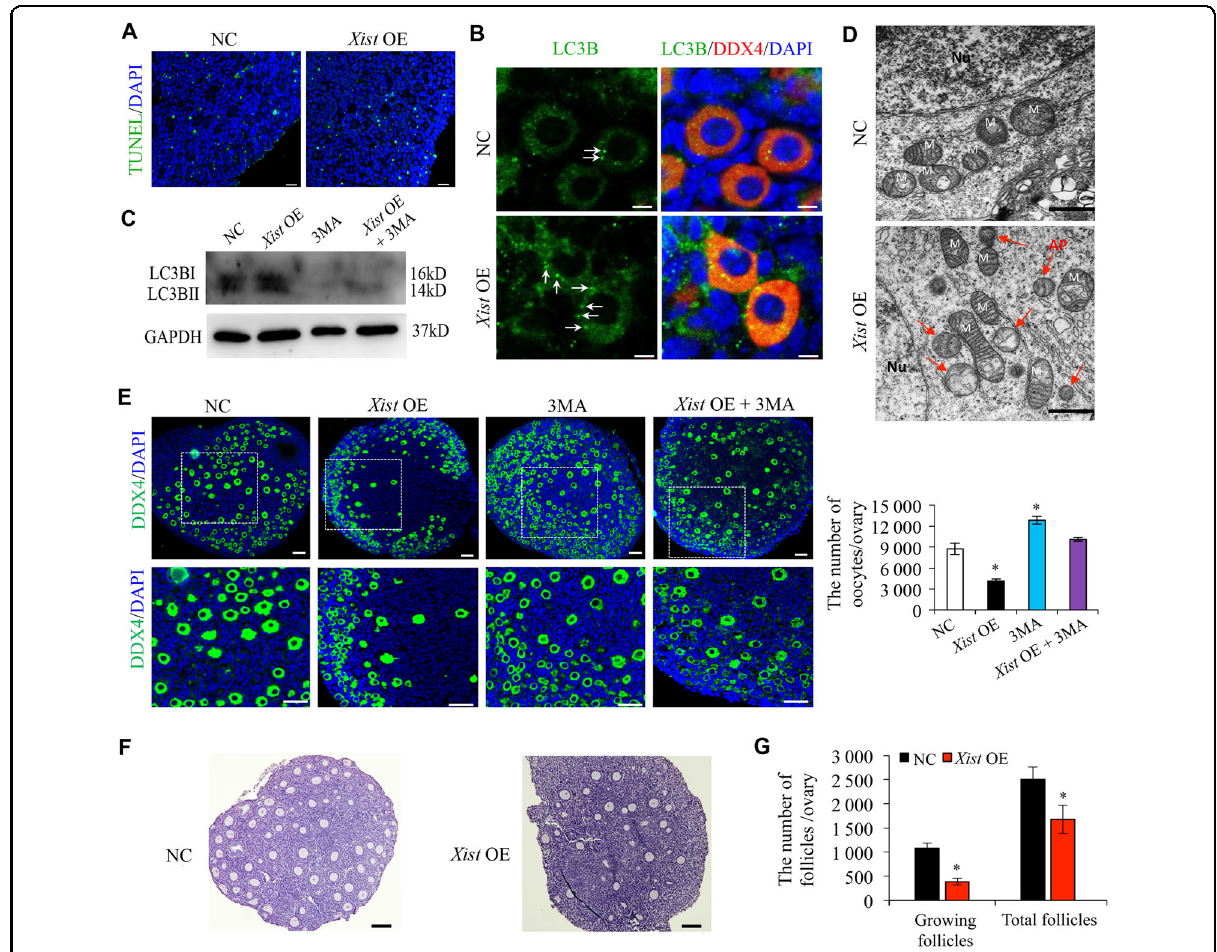
Fig. 2 Xist promotes oocyte autophagy during PF formation. a TUNEL staining in newborn ovaries transfected with Xist -pcDNA3.1 ( Xist OE) or the empty vector control (NC). The nucleus was stained by DAPI (blue). Scale bars: 20 μ m. b Immuno fl uorescence staining of LC3B (green), and DDX4 (red) in newborn ovaries transfected with Xist -OE compared to NC control. Scale bars: 5 μ m. Arrows indicating LC3B puncta. c WB analysis of active LC3B expression in newborn ovaries treated under indicated condition. d TEM analysis of autophagosomes in newborn ovaries transfected with Xist - OE compared to NC control. Red arrow indicating autophagosomes. Scale bars: 1 μ m. e Representative images of DDX4 immuno fl uorescence staining (left) and quanti fi cation of follicles (right) in newborn ovaries treated under indicated condition. The nucleus was stained by DAPI (blue). Scale bars: 50 μ m. f , g Representative images ( f ) and quanti fi cation of follicles ( g ) in the ovary transfected under indicated condition. Scale bar, 20 μ m. Student ’ s t- test: * P <